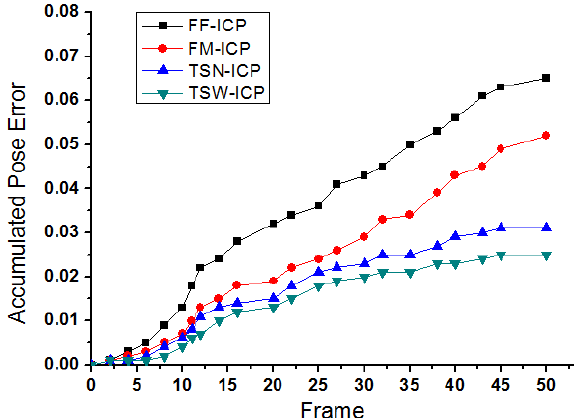
Figure 13. The result of accumulated pose error from frame to frame ICP method (FF-ICP), the frame to model ICP method (FM-ICP), two-step pose estimation method without adaptive weight (TSN-ICP) and two-step pose estimation method with adaptive weight (TSW-ICP). The results show that TSW-ICP can effectively improve the accuracy of pose estimation.